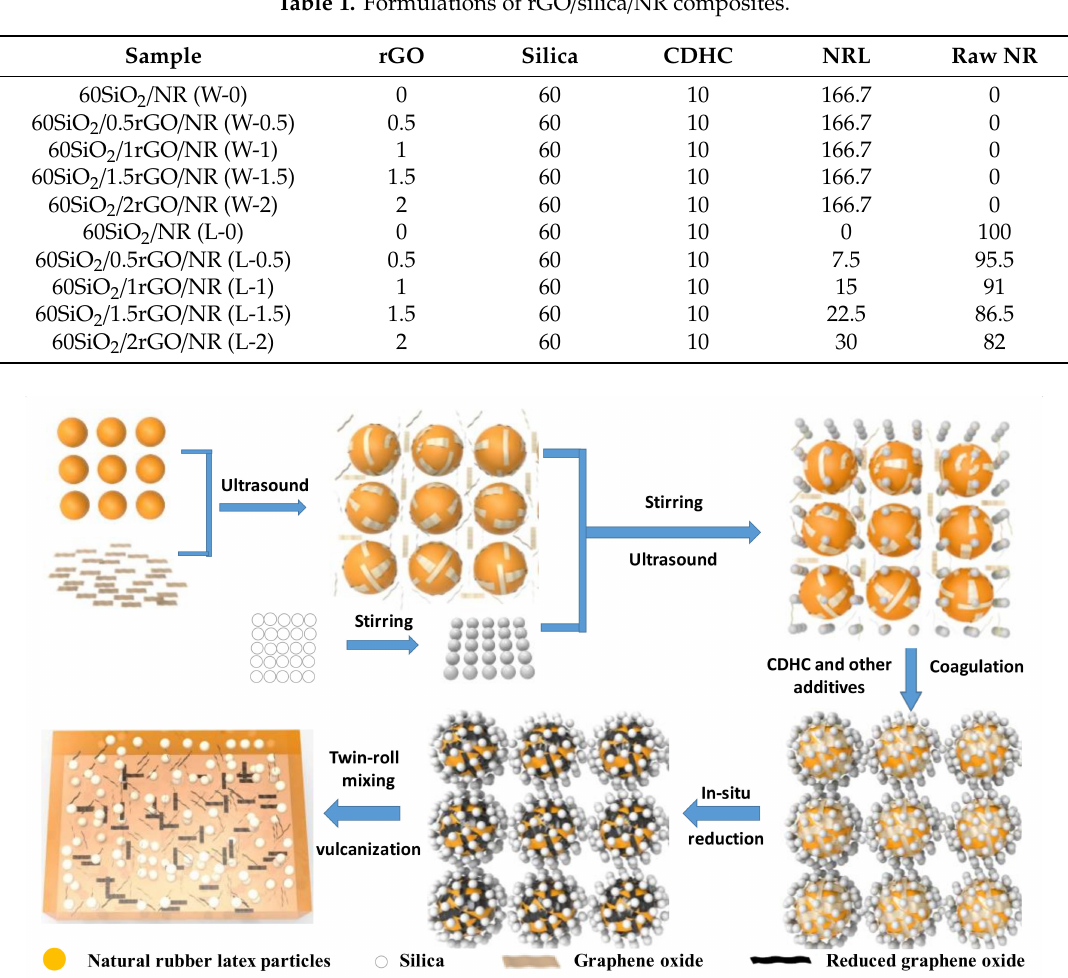
Table 1. Formulations of rGO / silica / NR